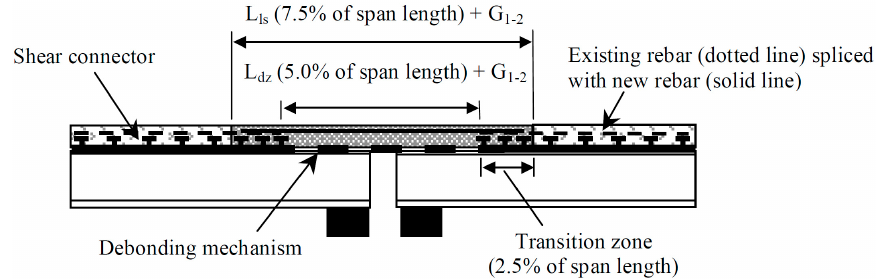
Figure 12. Schematic of a link slab replacing a problematic movement joint in multi-span highway bridges subject to de-icing salt deterioration (adapted from [163] ).